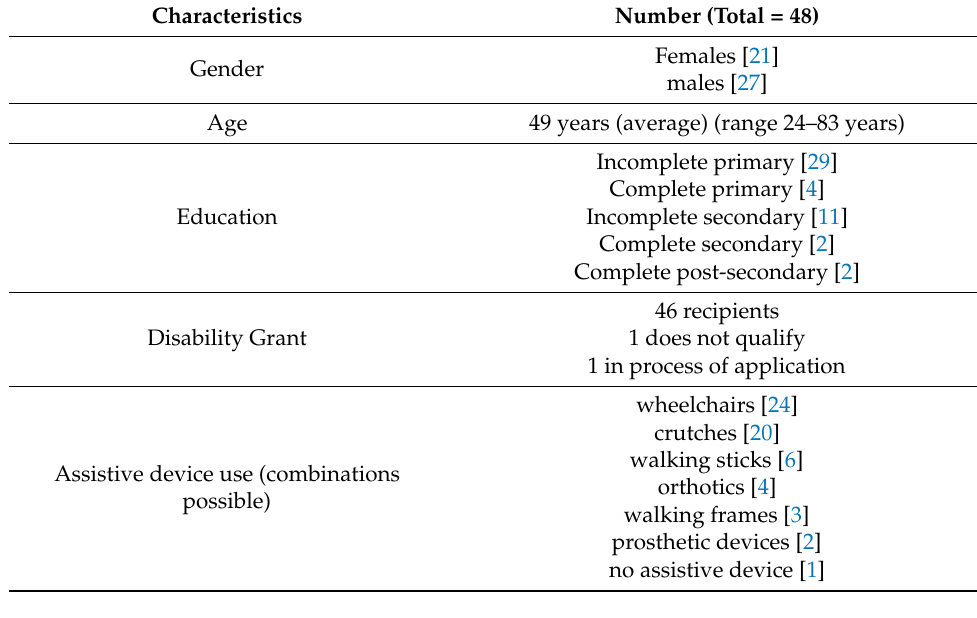
Table 4. Participant characteristics.